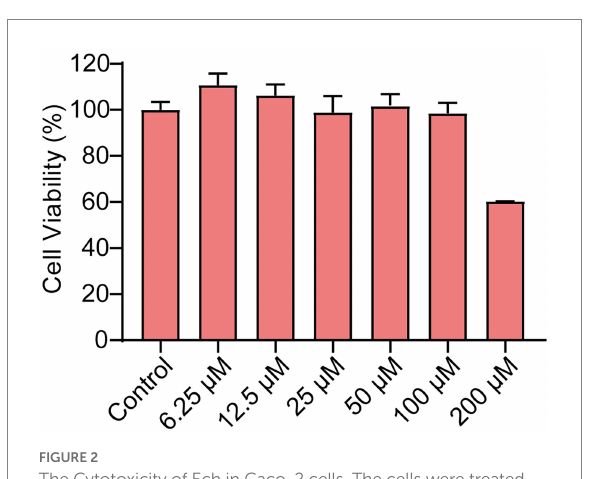
FIGURE 2 The Cytotoxicity of Ech in Caco-2 cells. The cells were treated with Ech at different concentrations (0, 6.25, 12.5, 25, 50, 100, and 200 μ M) for 24 h. Data represent means ± SD of three experiments conducted in triplicate.